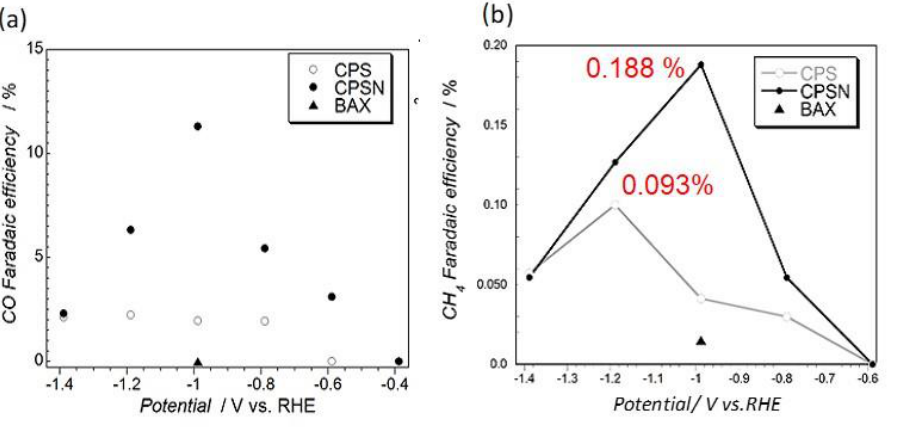
Figure 4. ( a ) Faradaic efficiency for CO and ( b ) for CH 4 formation on the carbons tested. Adapted with permission from Reference [48]. Copyright 2016, Wiley.